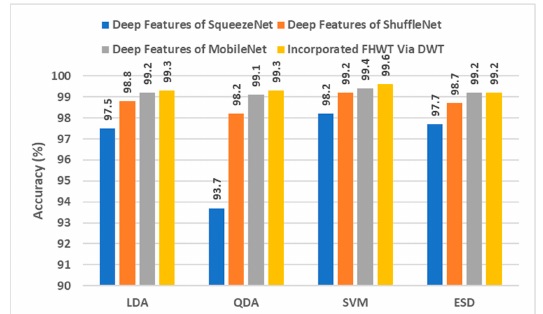
Figure 7. Classification accuracies (%) of deep features versus integrated FWHT features via DWT of the three CNNs.